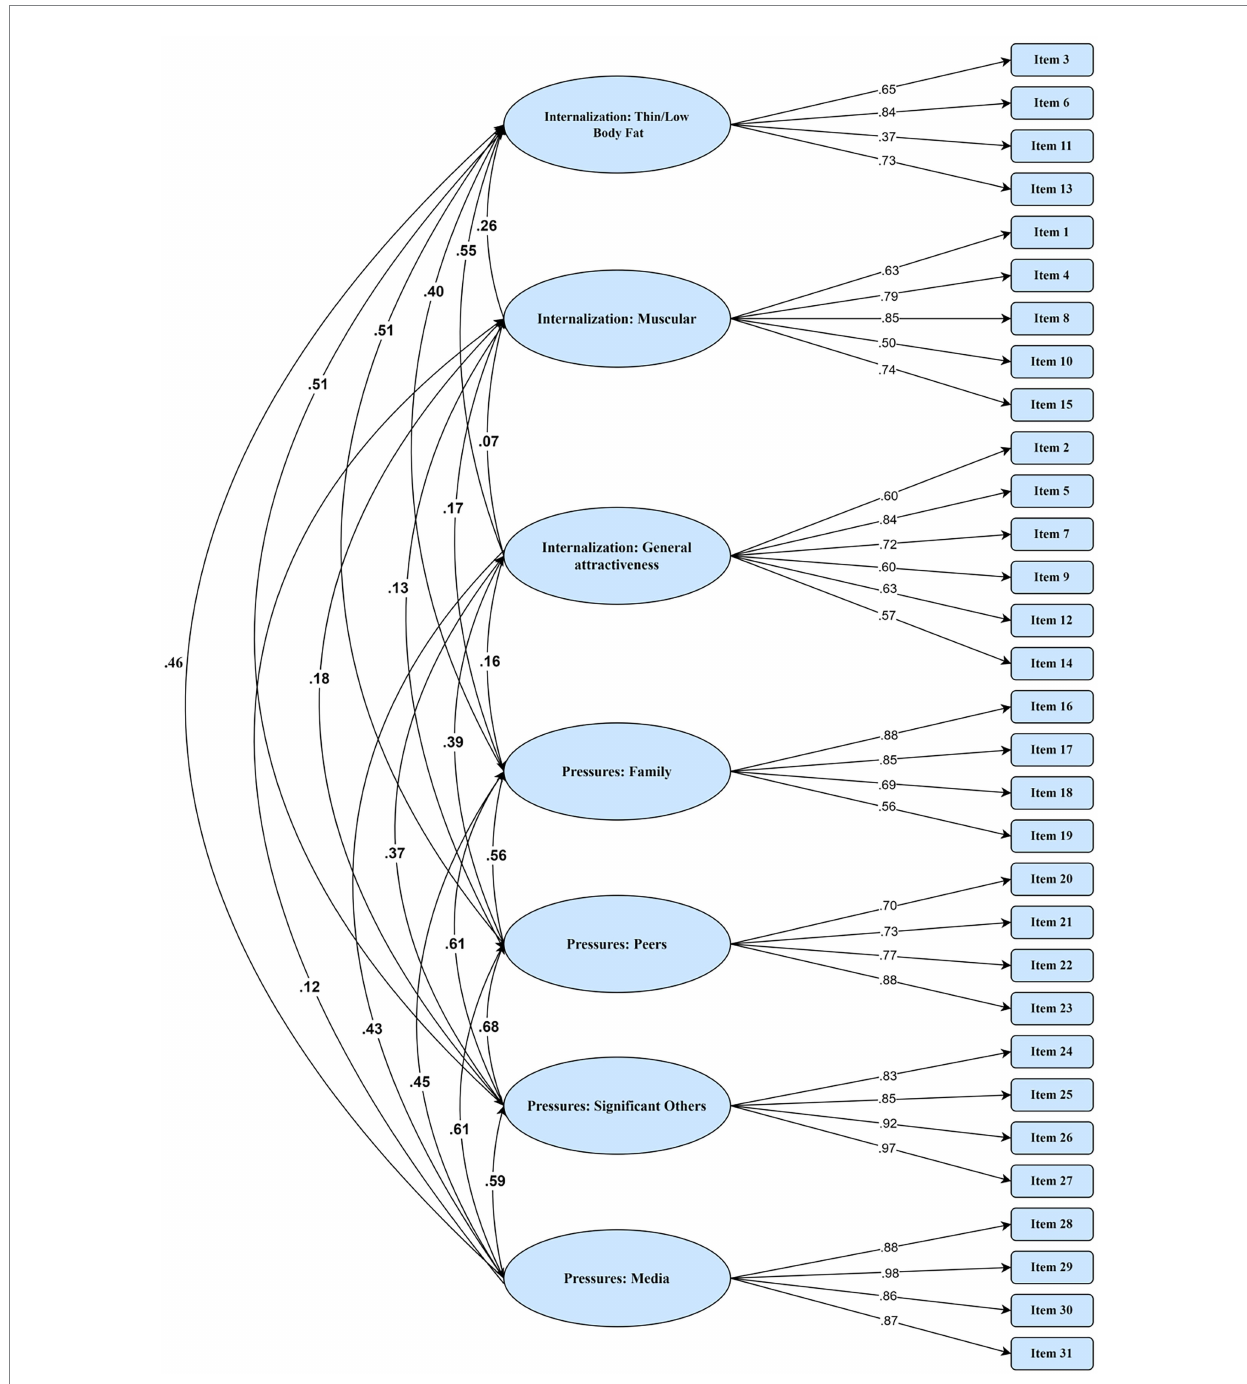
FIGURE 2 Confirmatory factor analysis for male